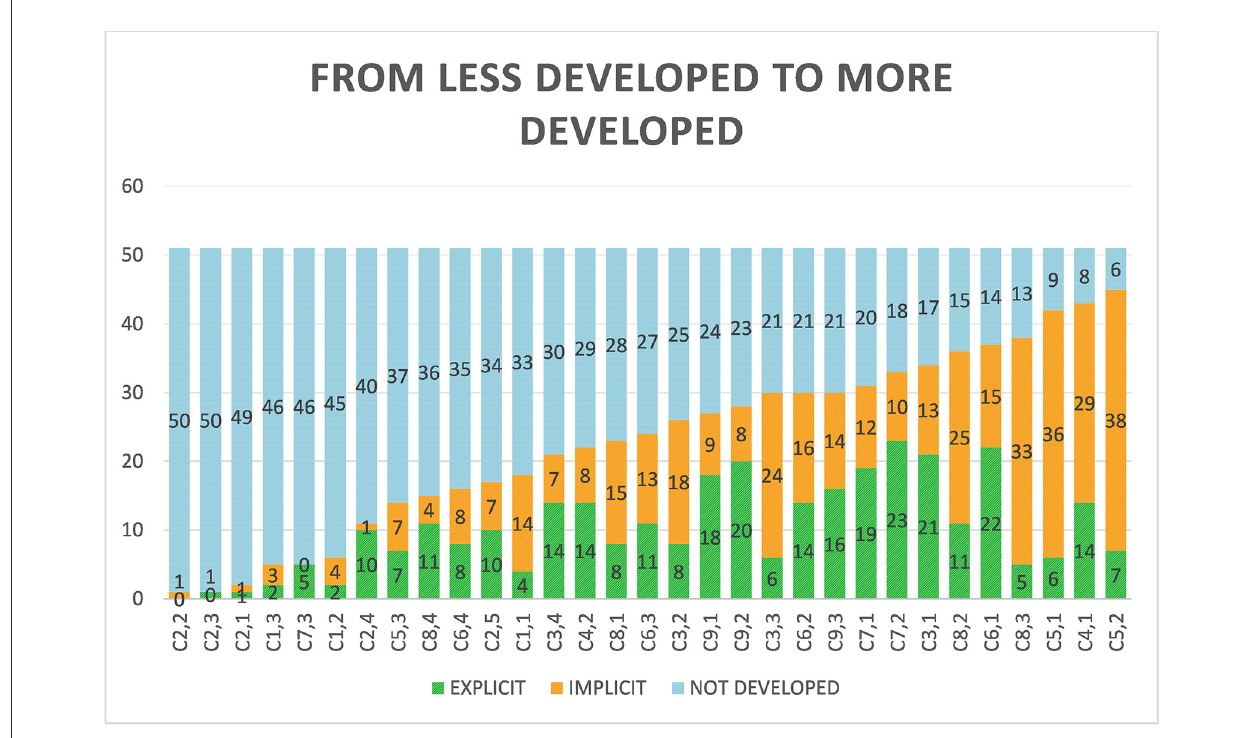
FIGURE6 Implicit, explicit, and not developed uses. Sorted from the most to the least not developed.